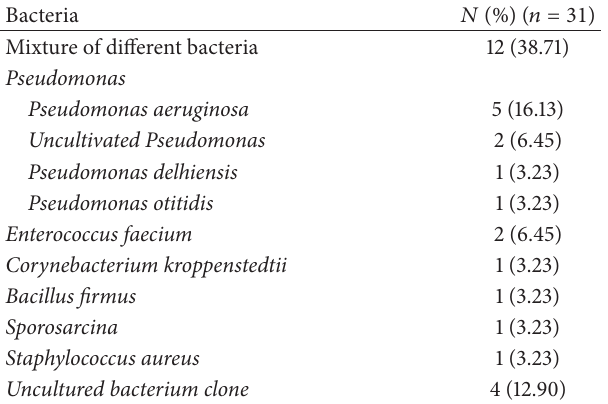
Table 6: The expressions of IFN- 𝛾 , IL-12A, and IL-17A in PDM compared with normal breast tissues.